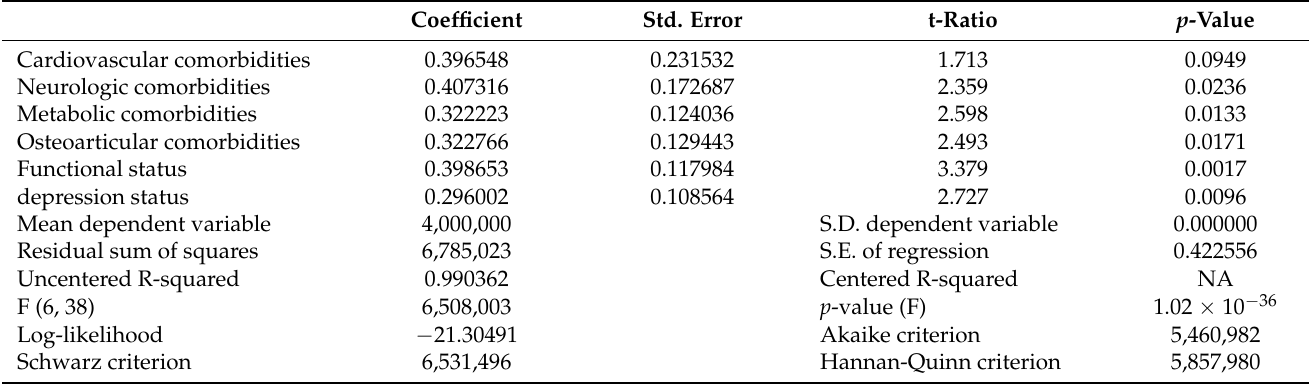
Table 10. Pearson coefficient correlation in the Model CONTROL GROUP: OLS (Dependent variable: COGNITIVE STATUS) shows a lack of correlation between comorbidities, functional status, and depression in the control group (S.D.= standard deviation; S.E.= standard error). Coefficient Std. Error